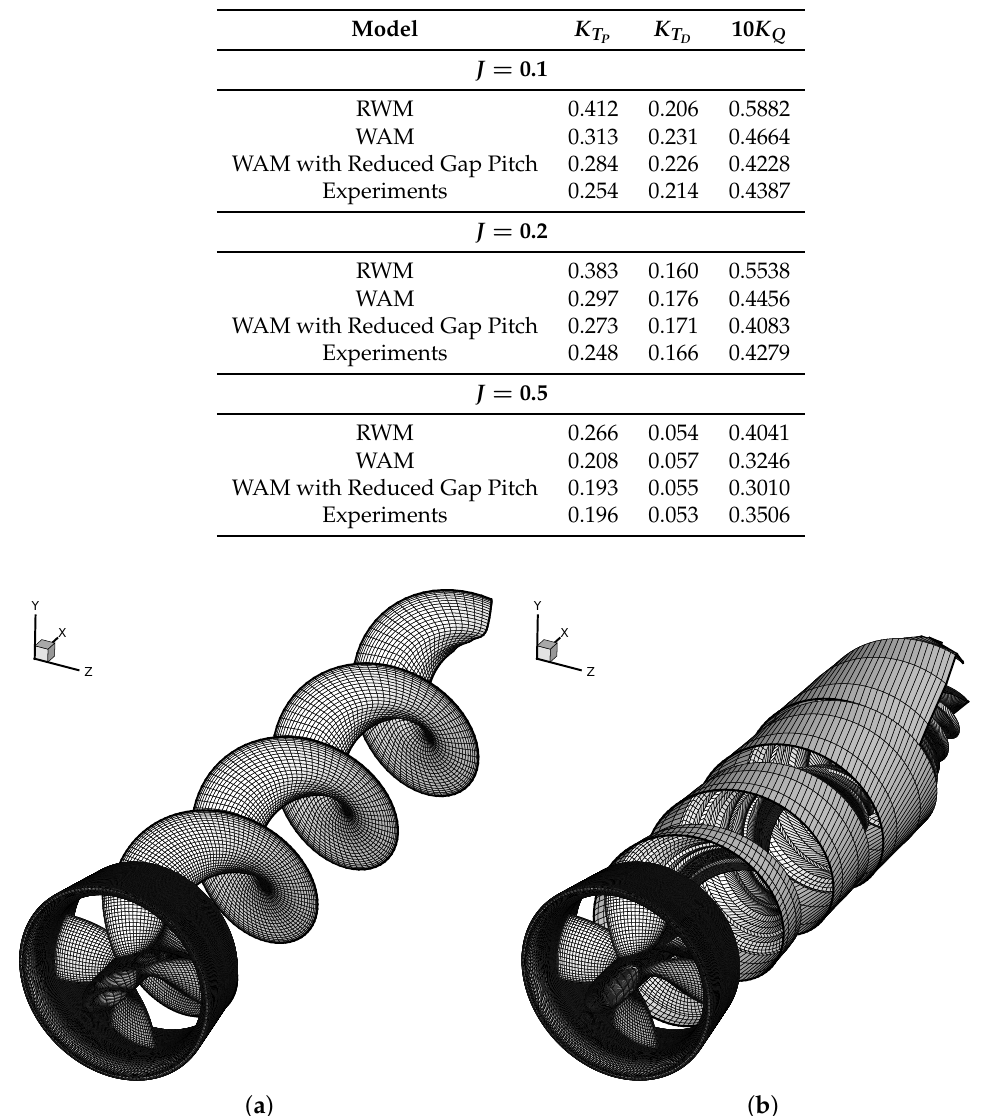
Figure 5. Panel arrangement for propeller blades, duct, hub and blade wake at J = 0.2. Rigid wake model ( a ); Wake alignment model ( b ). Only one wake surface is